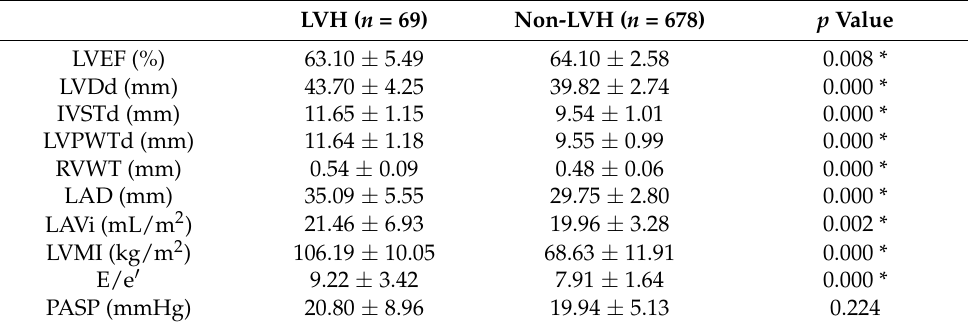
Table 2. Echocardiographic and vascular function indexes of the study population.